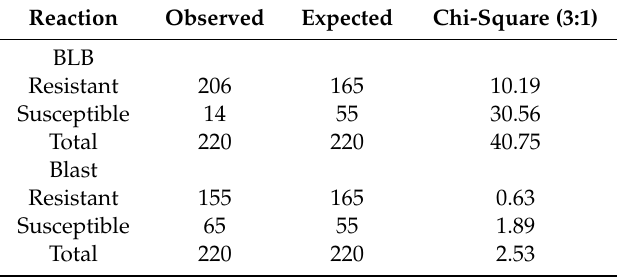
Table 5. Observed and expected segregation ratios of resistant and susceptible plants in the BC 2 F 2 generation challenged with pathotype P7.7 and P7.2 of Xoo and Magnaporthe oryzae .